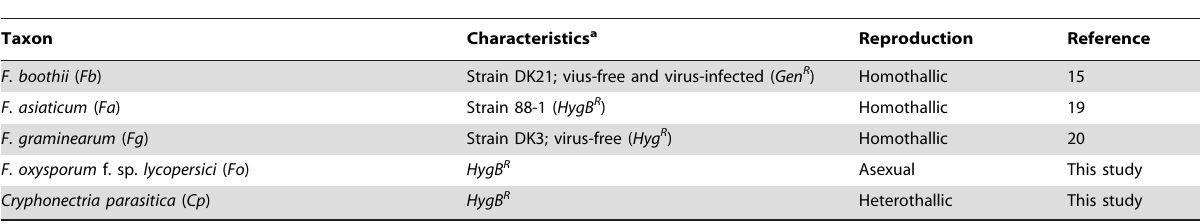
Table 1. Strains included in this